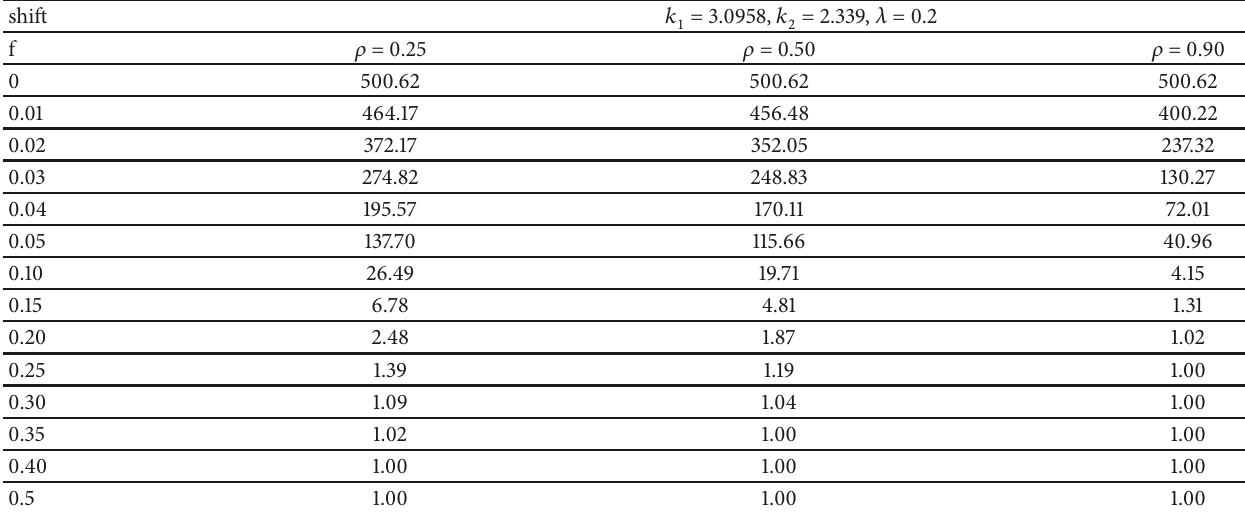
Table 2: ARLs for proposed repetitive EWMA-RSS control chart using Bahl and Tuteja (1991) exponential ratio-type estimator, when 𝑟 𝑜 is 500.